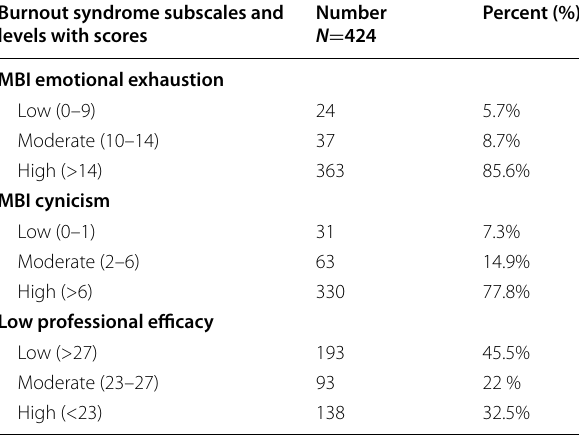
Table 2 Prevalence of burnout syndrome among students from the College of Medicine, University of Kerbala, according to the subscales Burnout syndrome subscales and levels with